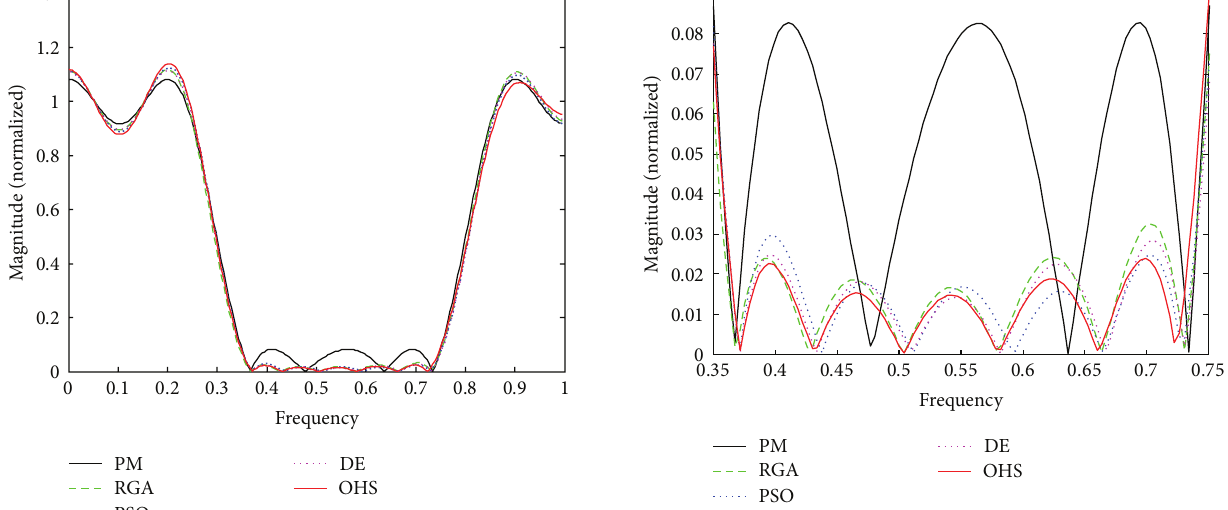
Figure 14: Normalized plots for the FIR BS filter of order 20.